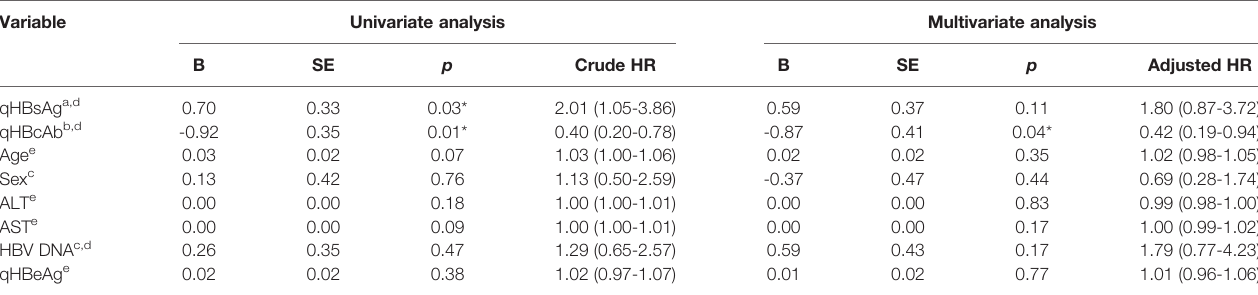
TABLE 2 | Risk factors for HBV recurrence after liver transplantation.